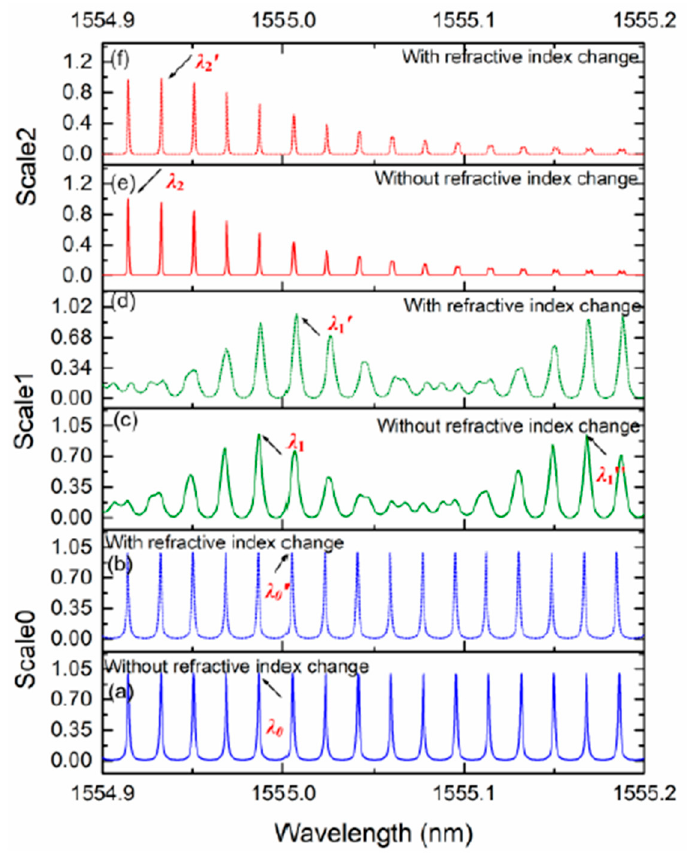
Figure 7. ( a ) Normalized transmission spectra of Scale 0 without (normal line) and ( b ) with a change in refractive index (dashed line). ( c ) Normalized transmission spectra of Scale 1 without (normal line) and ( d ) with a change in refractive index (dashed line). ( e ) Normalized transmission spectra of Scale 2 without (normal line) and ( f ) with a change in refractive index (dashed line).